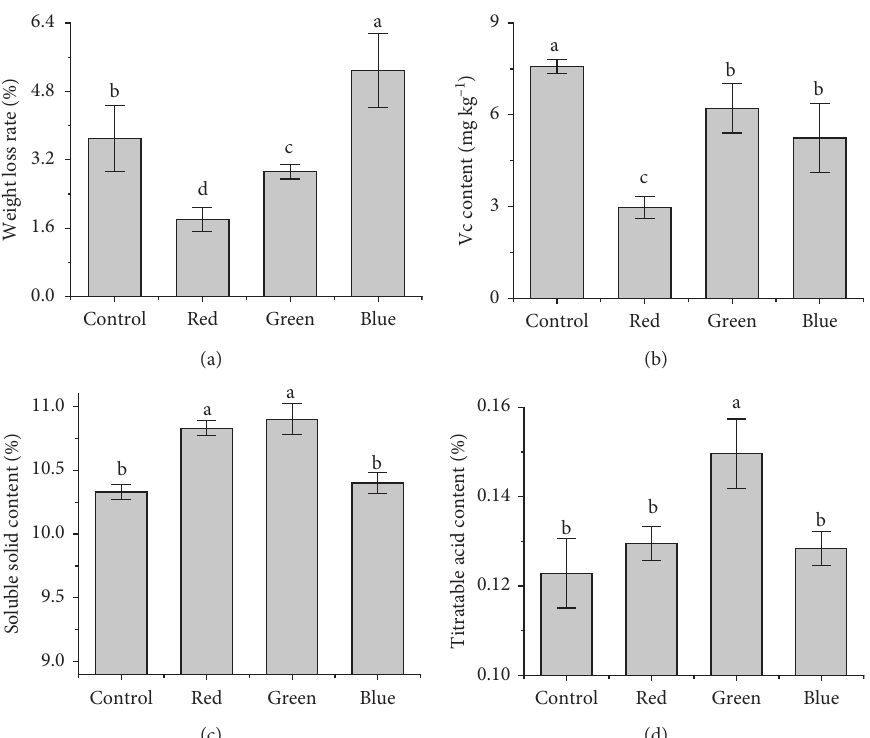
Figure 4: Effect of light exposures on weight loss (a), Vc content (b), soluble solid content (c), and titratable acid (d) of fresh-cut wa- termelon. Data are mean ± standard deviation ( n ≥ 3). Means with different letter represent a significant difference ( P < 0 .